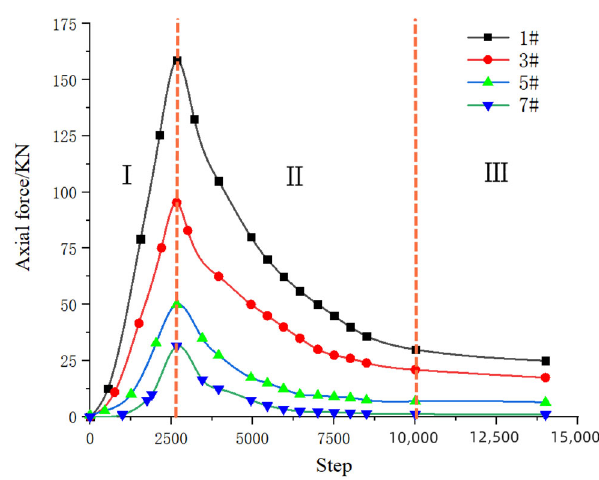
Figure 11. Axial force distribution law of measuring point.